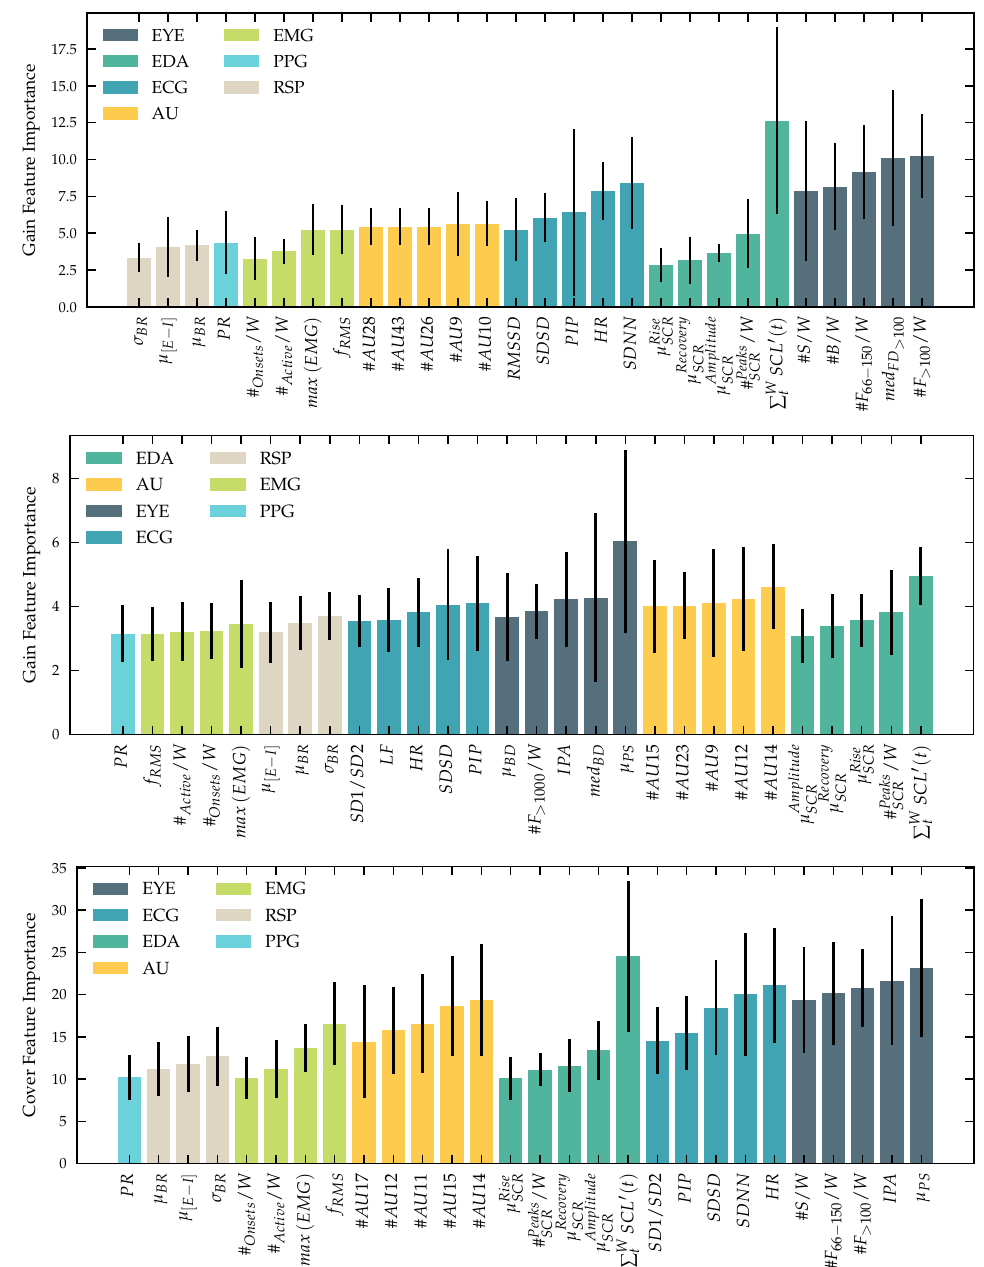
Figure A4. XGBoost gain feature importance of single and dual task k -drive (first row) and n -back (second row), using binary classification (high/low CL) and XGBoost coverage feature importance for single and dual-task n -back and k -drive in the last row. The feature-modality-groups (colors) are ordered by the importance of the complete group with the highest importance on the right and the lowest importance of the complete group on the left. We drop features with very low importance for visual